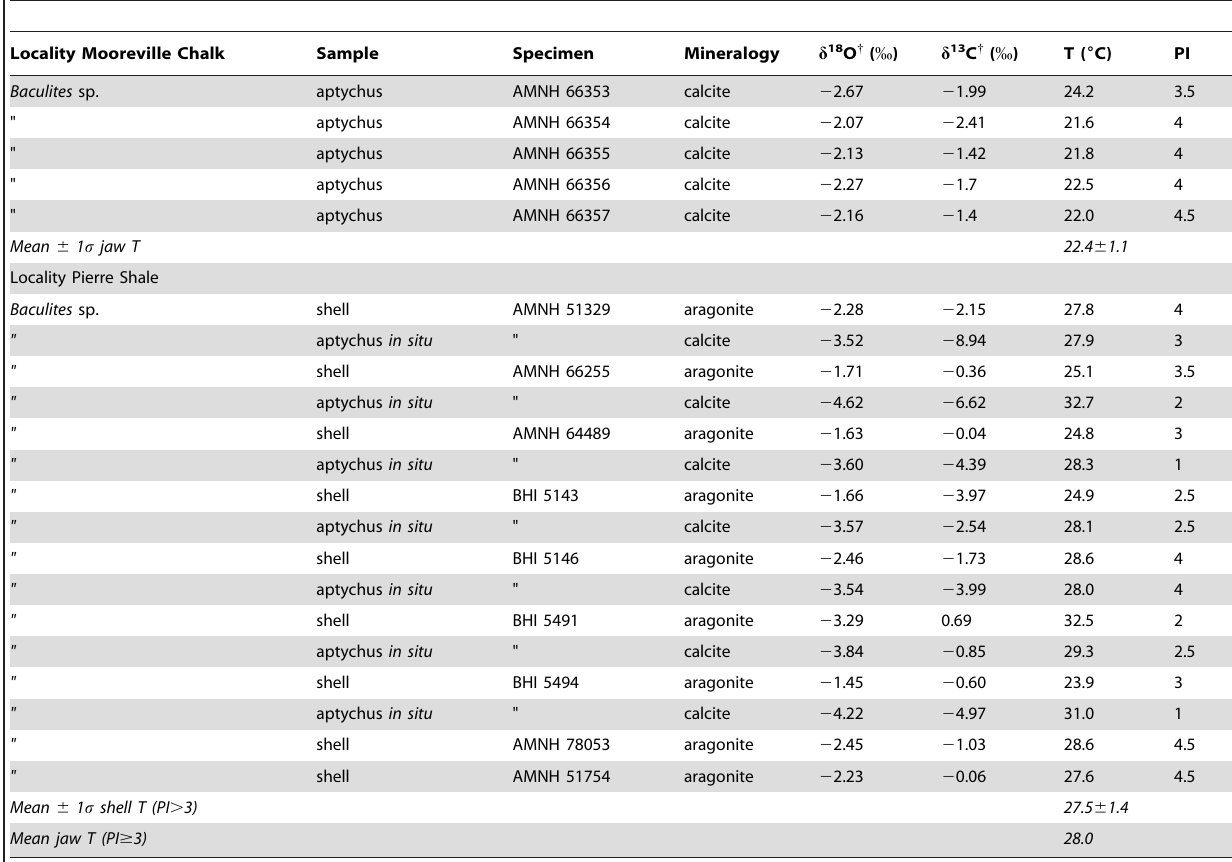
Table 2. Isotope data for ammonites.